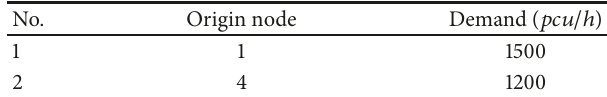
Table 2: Information of evacuation demand.